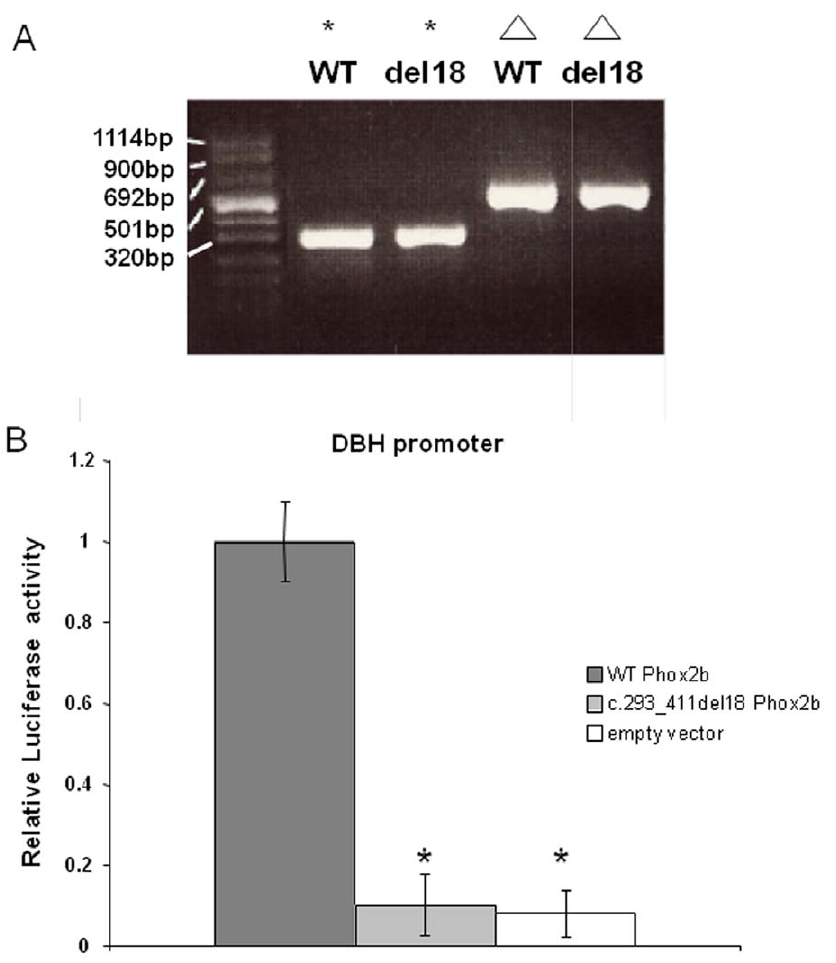
Figure 3. Functional assays on the PHOX2B c.393_410del18 mutation (A) Reverse transcribed PCR analysis of Hela cells transfected with the respective Exontrap wild type and mutated exon 2 constructs. Wild type and the 393_410del18 mutated inserted human Phox2b sequences into Exontrap vectors in the correct 5 9 - . 3 9 orientation have spliced their exon 2 (indicated by a triangle) as expected (approx. 500 bp, 5 9 and 3 9 exons of Exontrap + Phox2b exon2) demonstrating that the c.393_410del18 mutation does not seem to affect the splicing of the exon2 of Phox2b. In contrast when the exon 2 human Phox2b sequence is inverted 3 9 - . 5 9 (indicated by an asterisk) within the Exontrap construct for the wild type as for the mutated sequence, the entire Phox2b insert + Exontrap-introns sequences are spliced out (approx. 300 bp). (B) Transactivation of the DBH promoter. The error bars indicate SD for n=3 duplicate experiments. Each luciferase activity has been normalized with an internal control (pRL- CMV, Promega). In each experiment, the activity of the wild type protein was set to one, and the results are shown as the ratio between the activities of the mutant and the wild-type proteins. Significant differences between the wild-type and the specific mutant are indicated by an asterisk (Student’s test, *p ,